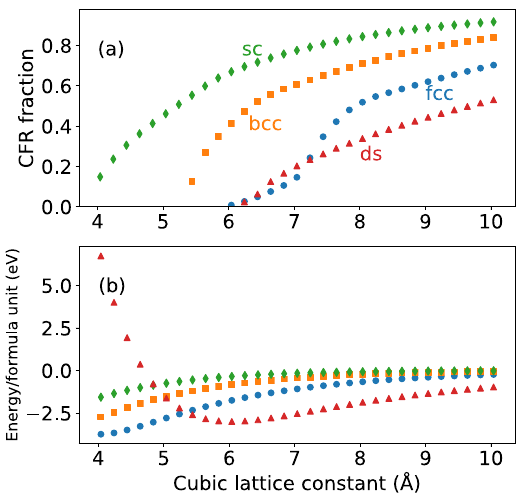
Fig. 7 CFRs of a few crystalline and magnetic phases in NiO. a Spin CFRs and b relative energies of AFM NiO (AF2-rs and AF5-zb) and CFR of Unp. NiO (rs) as a function of the cubic lattice constant, as calculated with PBE in VASP. The spin-up and spin-down CFRs for AFM-rs and AFM-zb NiO are identical. The Unp. rs phase of NiO was taken to contain one formula unit in the computational cell, the AFM rs (zb) phase to contain two (four) formula units in the computational